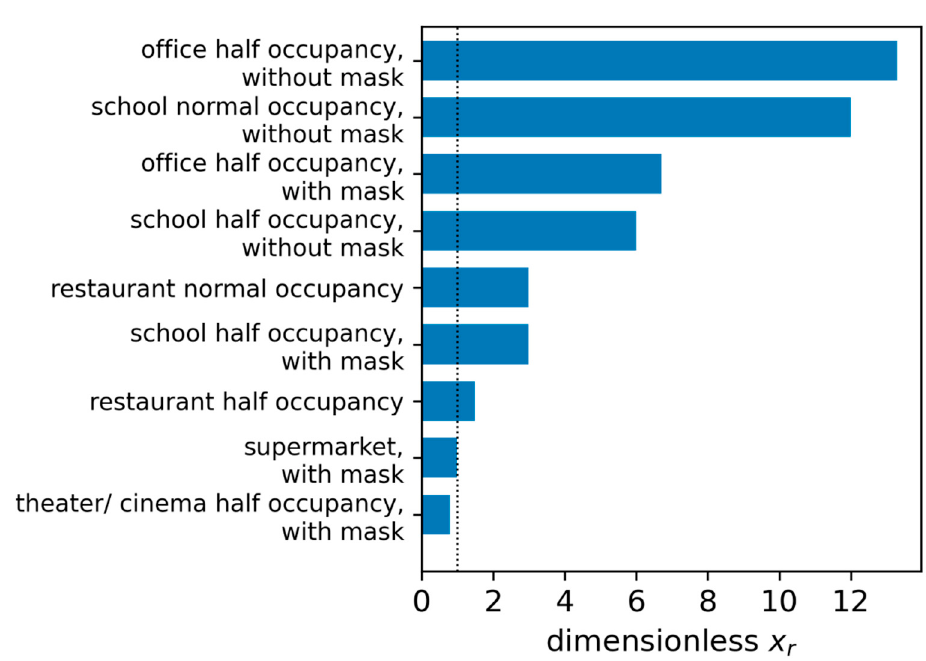
Figure 6. Comparison of the risk factor x r for different everyday life situations with a 0.5 h stay in a supermarket, wearing a mask as reference.